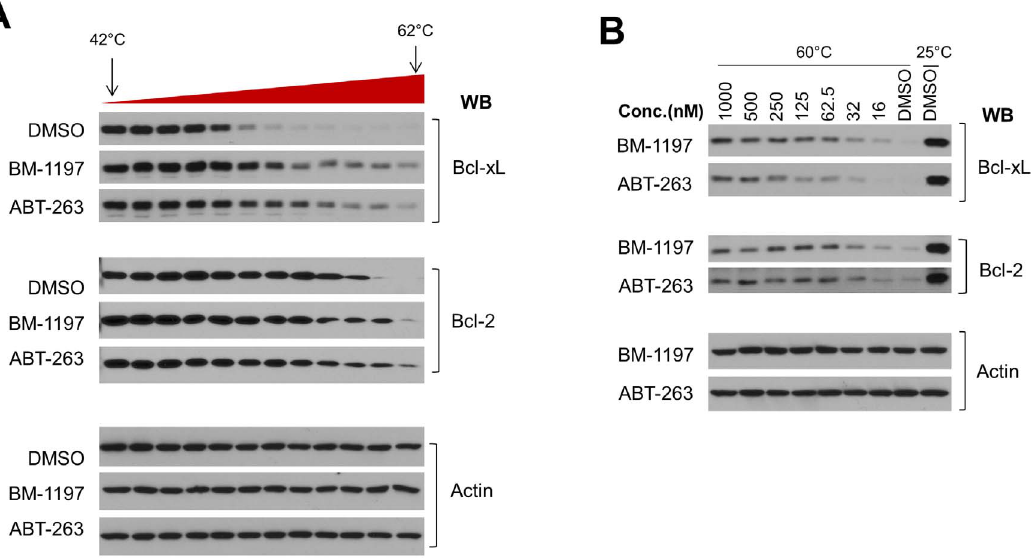
Figure 3. (A) MEF MCL1 2 / 2 cells were treated with DMSO, or 1 m M of ABt-263 or BM-1197 for 1 h. Drug-treated cells were heated at gradient temperature from 42 u C to 62 u C for 3 min then freeze-thawed 4 times. The soluble fractions of the lysed cells were analyzed by immunoblotting. (B) MEF MCL1 2 / 2 cells were treated with drugs at the indicated doses for 1 h before collected for CETSA.